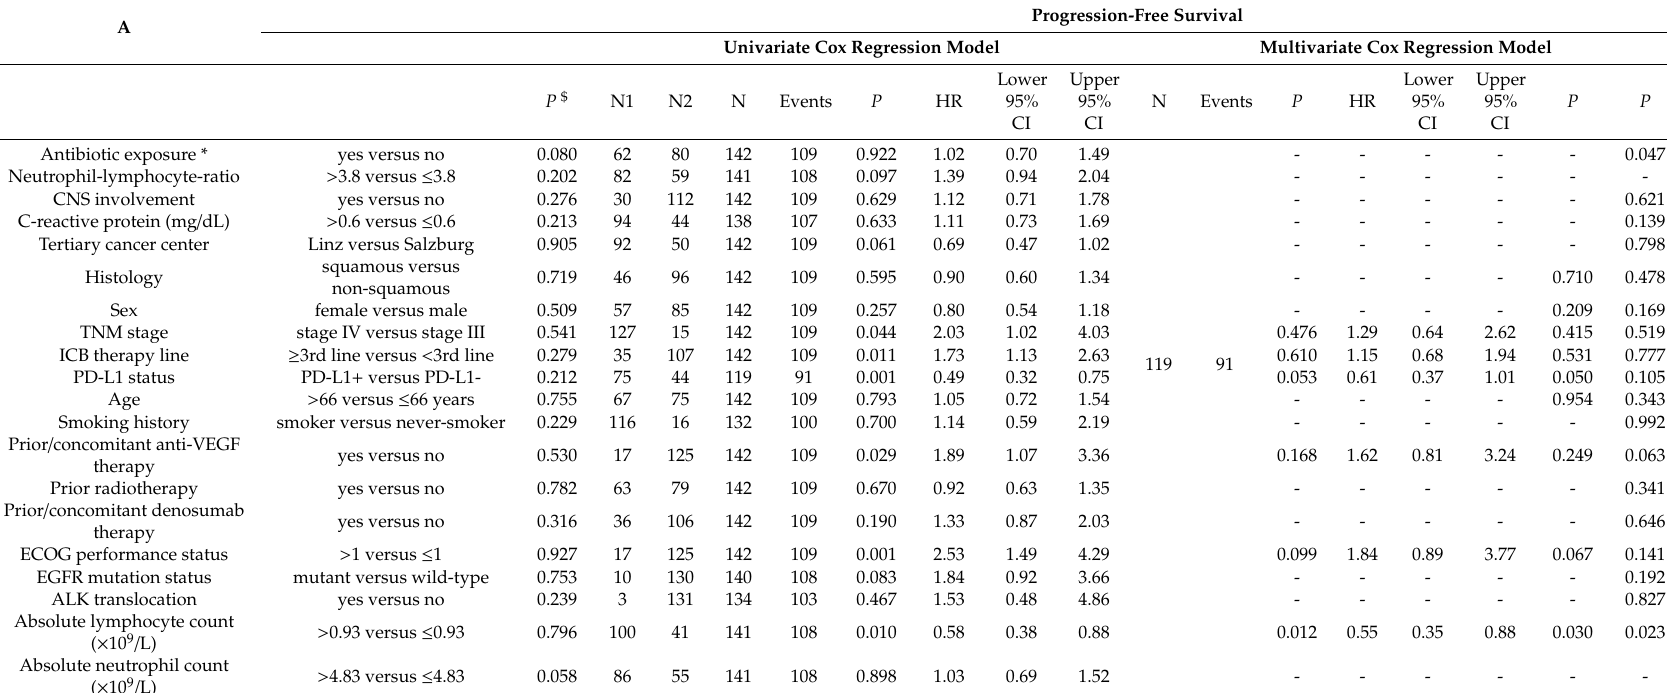
Table 2. Univariate and multivariate analysis for PFS (A) and OS